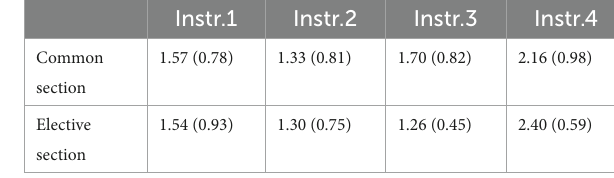
TABLE 3 Level of cognitive demand [1-low, 2-medium, 3-high]. Mean (standard deviation).